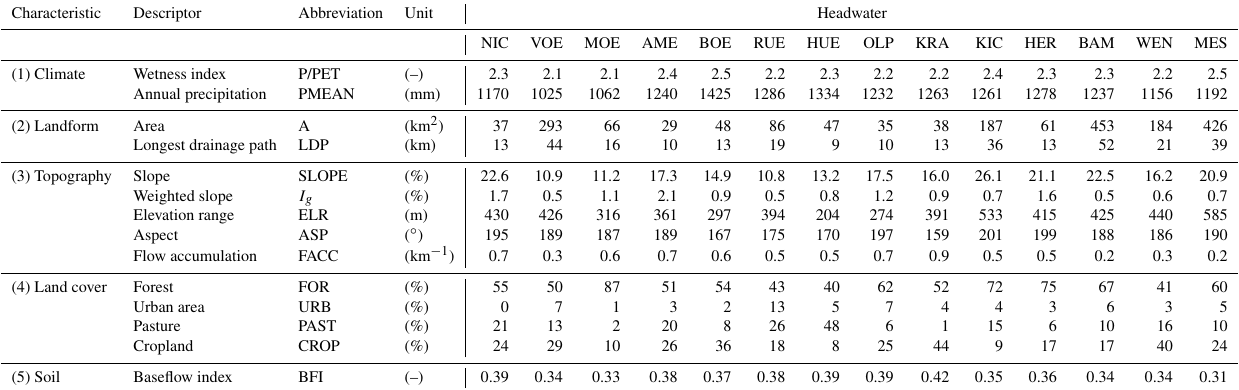
Table 3. Physiographic and climate descriptors characterising the topographic and hydroclimatic (1997–2006) setting of 14 Ruhr headwater